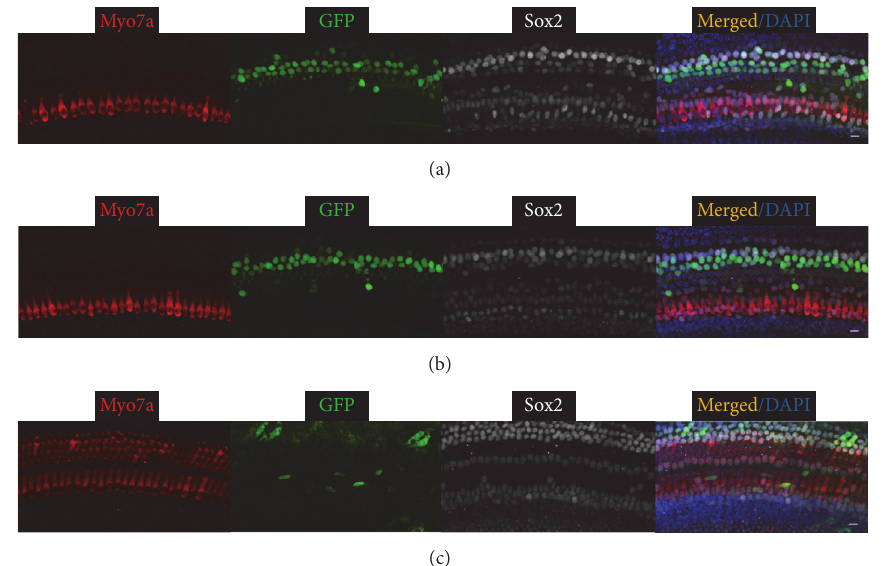
Figure 4: Ad-Cre-GFP-Baylor transduces supporting cells in the mouse cochlear when injected at P4. Representative confocal images of whole-mount fluorescent immunolabeling mouse cochlea to illustrate the basal (a), middle (b), and apical turns (c). Ad-Cre-GFP-Baylor transduces SCs at basal and middle turns efficiently. It transduces some SCs at the apical turn. Scale bars: 10 𝜇 m.